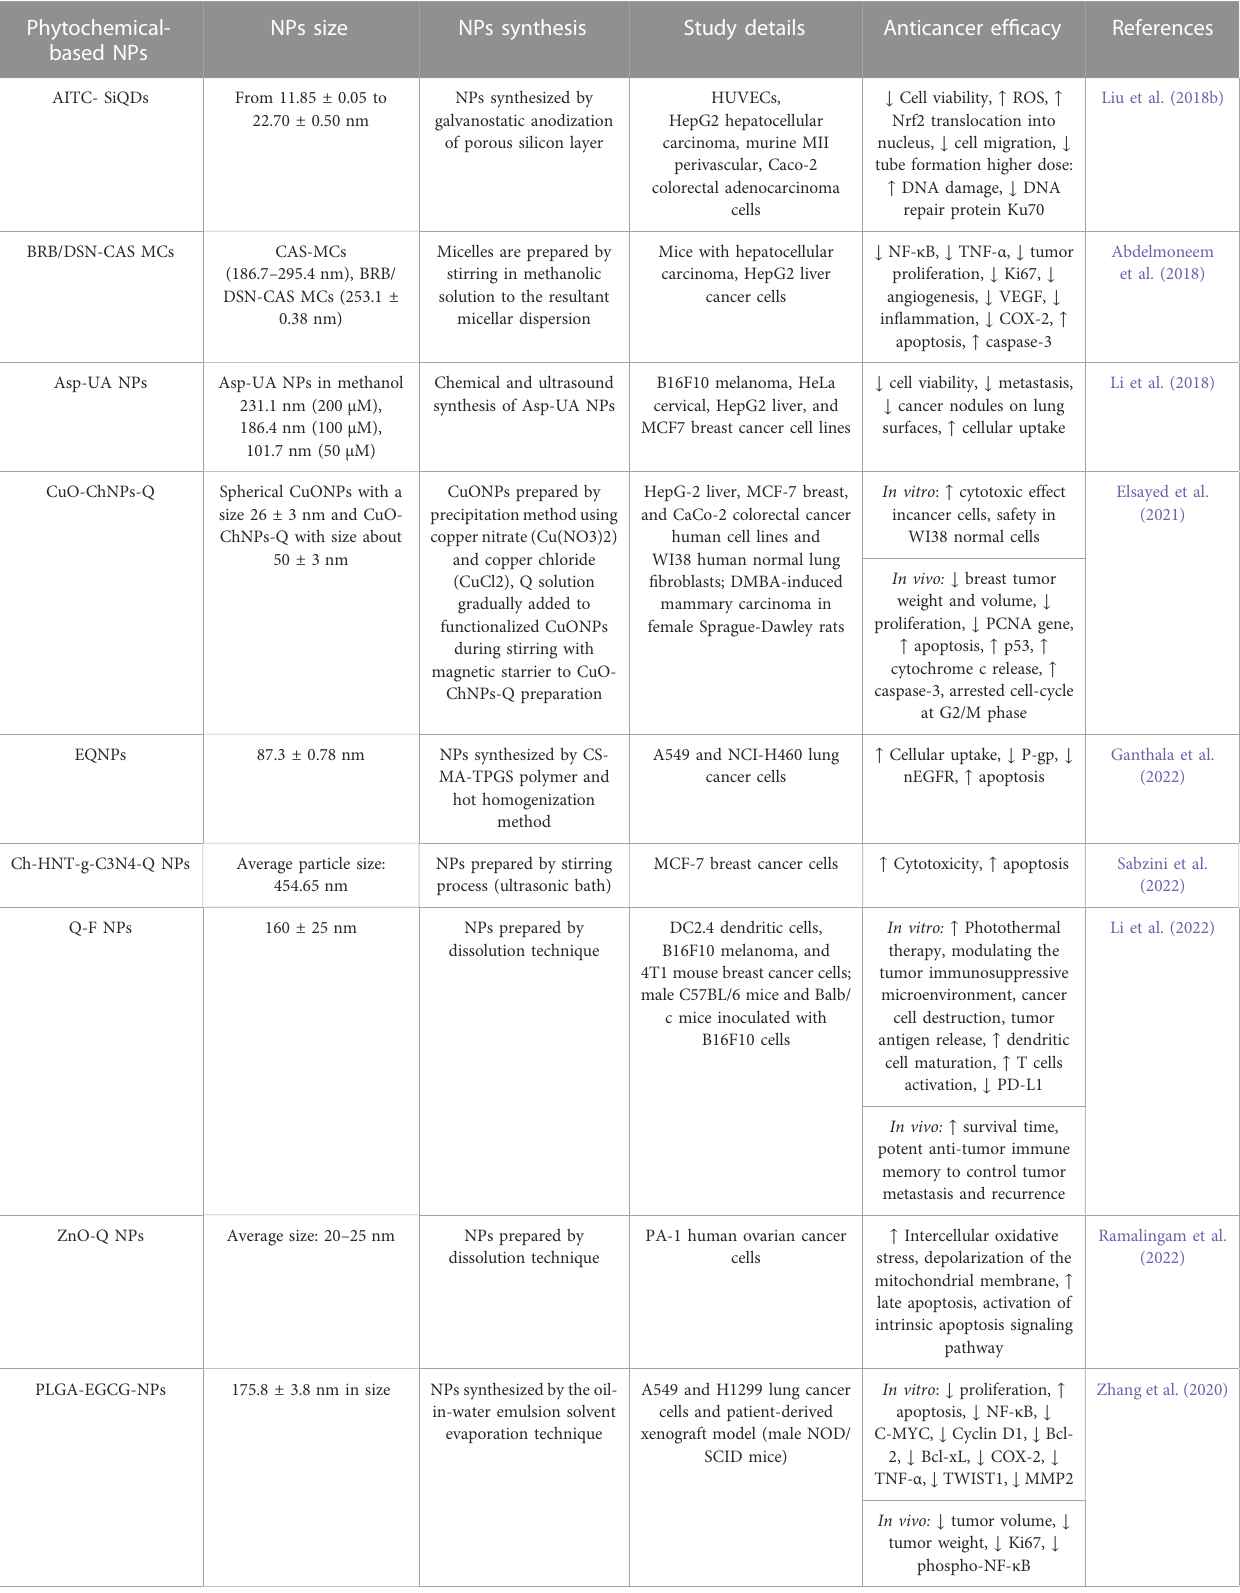
TABLE 2 ( Continued ) Anticancer effects of phytochemical-based